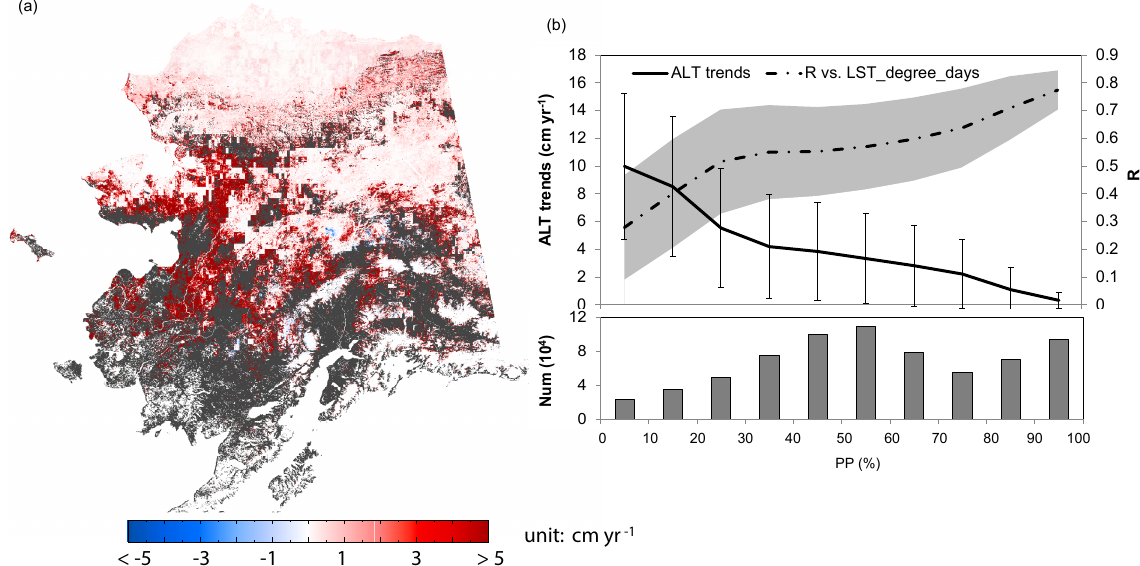
Figure 5. Model-simulated ALT trends and correlation with LST thawing degree days from 2001 to 2015: (a) simulated ALT trends over the Alaska domain, where areas with ALT > 3m are shown in dark gray, and (b) the distribution of ALT trends and correlations with MODIS LST degree days during the snow-free season (upper panel) within different permafrost probability (PP) zones (Fig. 3b). Vertical error bars (dark gray) indicate 1 standard deviation for the regional ALT trend and correlation coefficient, respectively. The number of 1km pixels represented within each PP zone is shown in the lower panel of (b)